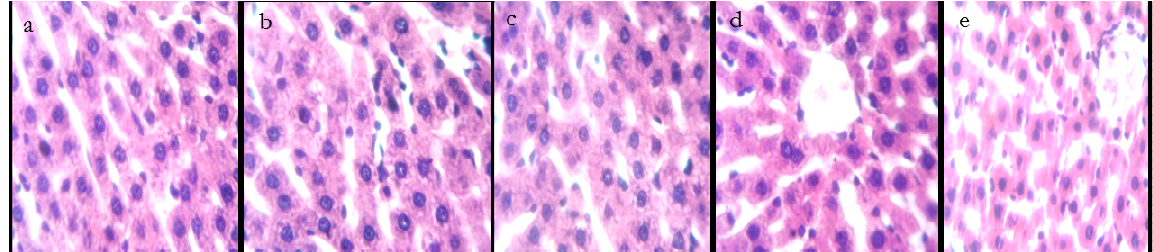
Fig. 7. Representative photomicrographs of liver section viewed under light microscope at magnification 400x; (a) control: showing no visible pathological alteration; (b) oliveoil: showing no visible pathological alteration; (c) curcumin: showing no visible lesion with normal histomorphology of the liver cells; (d) KBrO3: showing severe choleostatsis, the general histomorphology is perturbed (e) KBrO3+curcumin: showing typical presentation of liver histomorphology with no pathological alteration. Density and staining intensity appear normal with halo spaced central